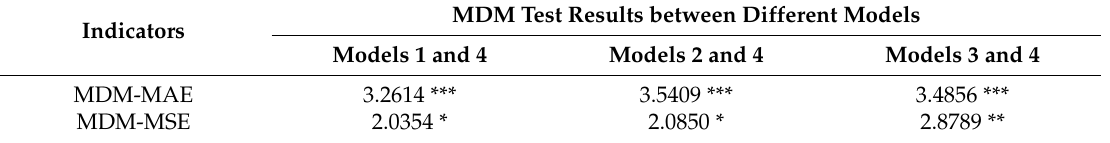
Table 8. Forecasting evaluation results based on the modified Diebold–Mariano (MDM)